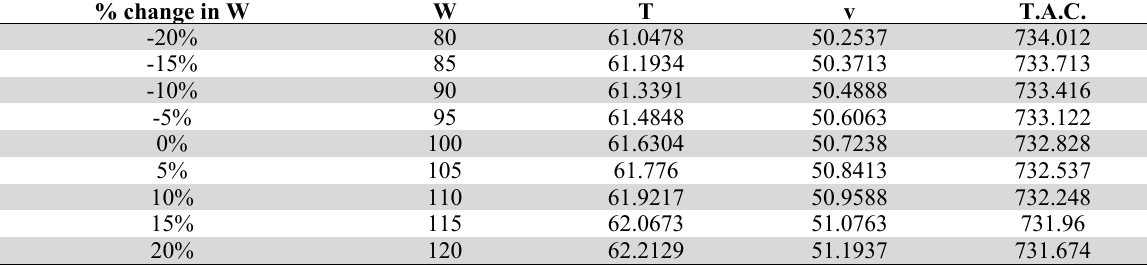
Fig. 7. Variation in total average cost w.r.t. backlogging parameter ( θ ) Effect on optimal solution for distinct values of warehouse capacity (W) % change in